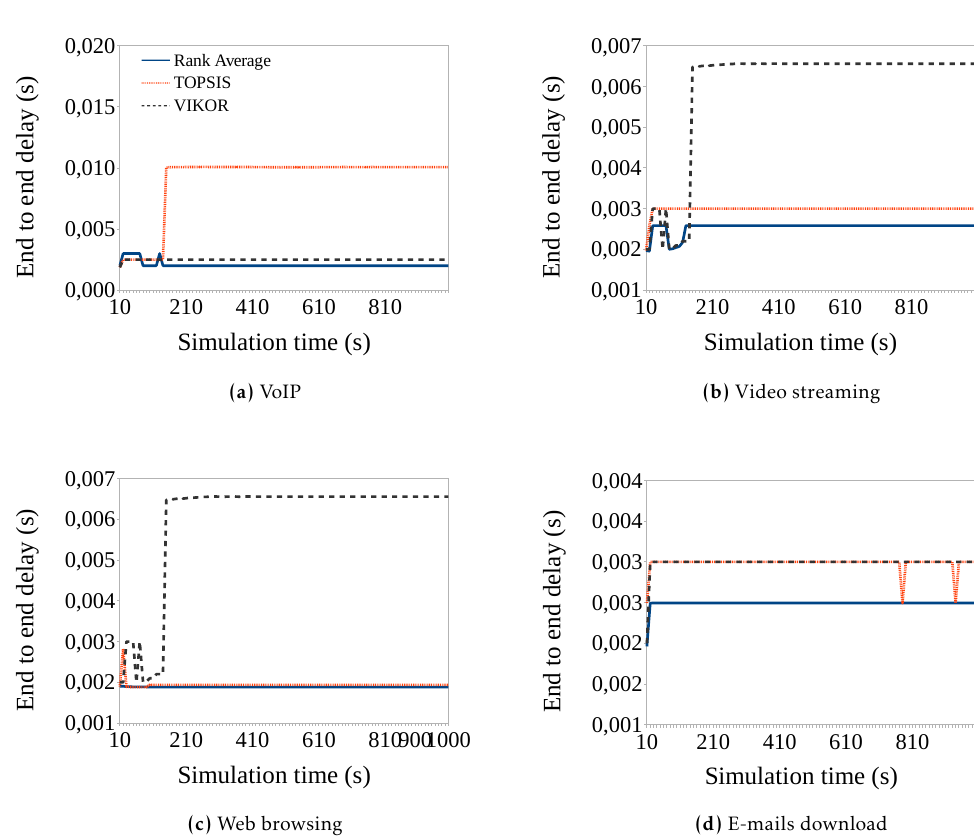
Figure 2. Packet end to end delay betweenMT and its